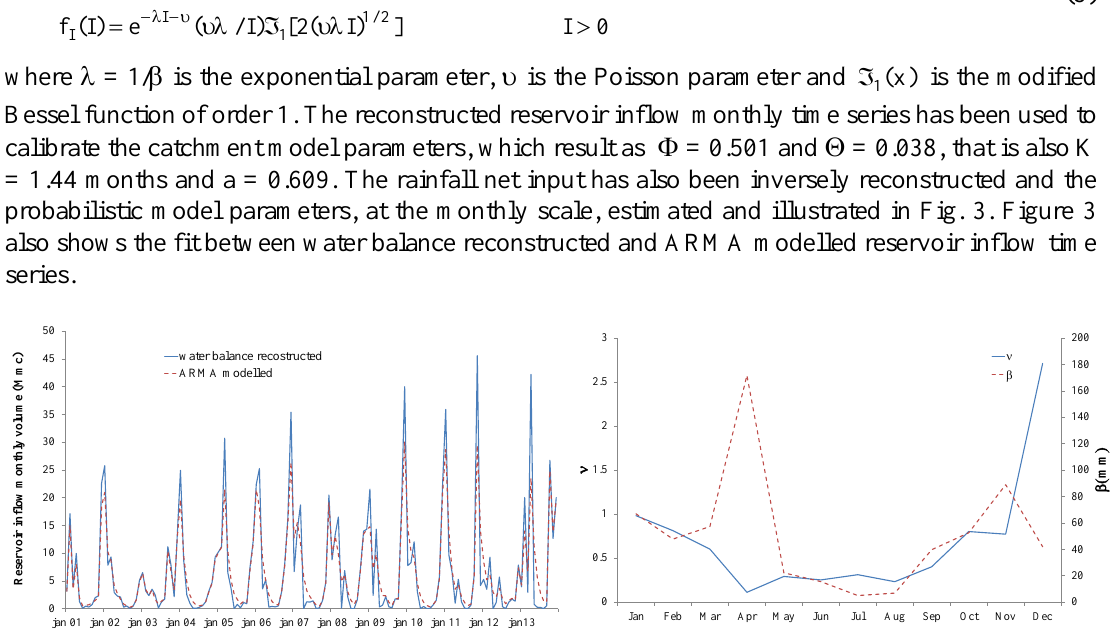
Fig. 3 Water balance reconstructed and modelled reservoir monthly inflow volume (left panel) and net rainfall input distribution ν and β parameters (right